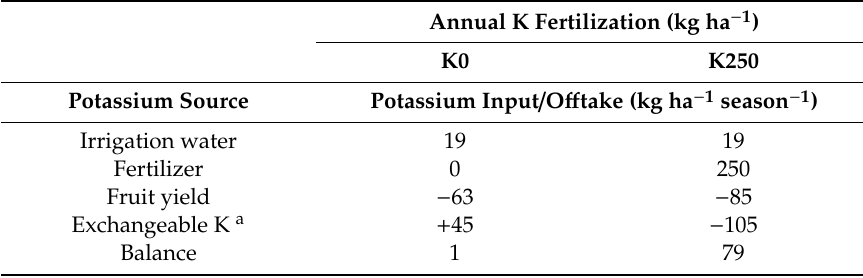
Table 7. Potassium